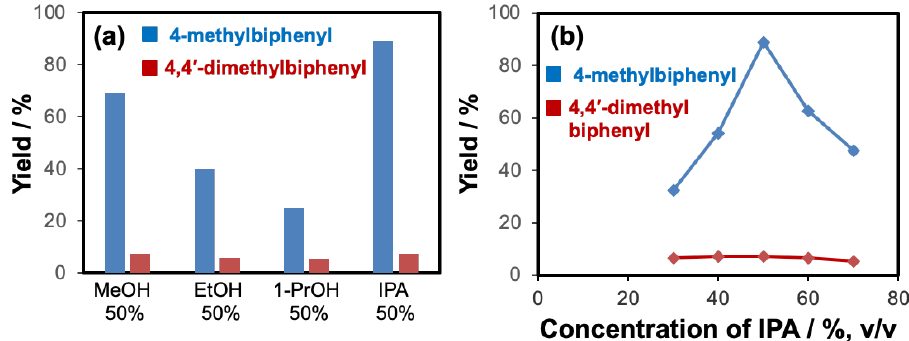
column (1 mm i.d. × 100 mm length).